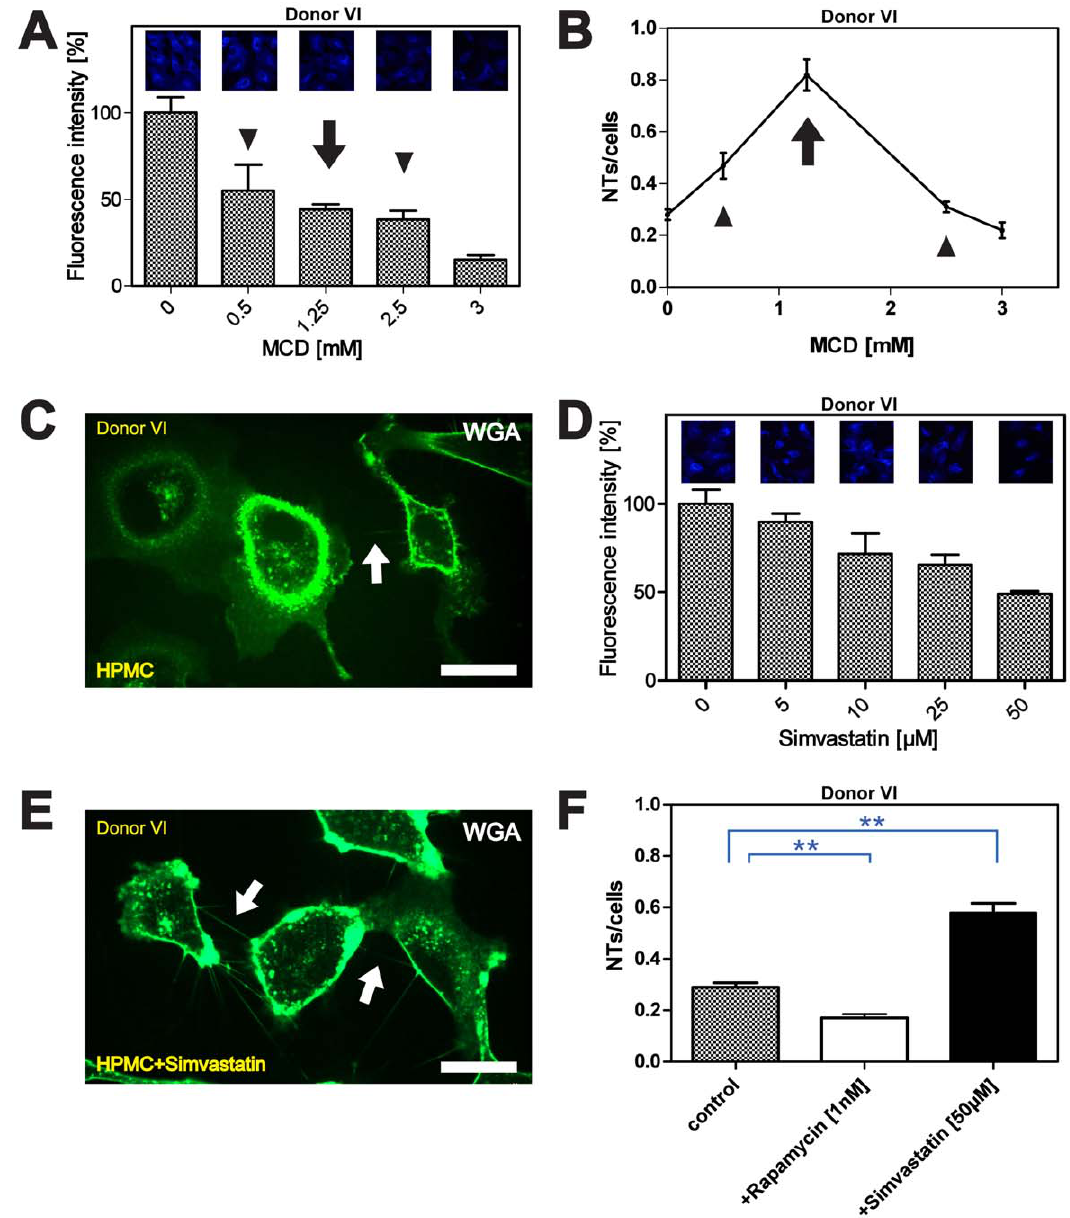
Figure 4. Influence of MCD and simvastatin on NT formation between HPMCs. ( A ) HPMCs from Donor VI were cultured in absence or presence of indicated MCD concentrations and Filipin III staining was performed one hour after plating. Cholesterol depletion results in a decrease of fluorescence intensities (arrowheads, arrow). ( B ) Analysis of the NTs/cells ratio dependent on cholesterol depletion. HPMCs were treated with indicated MCD concentrations and NT numbers were assessed one hour after cell plating. The graph shows a significantly higher number of NTs when cells are treated with 1.25 mM MCD (arrow) as compared to the control or treatment with 0.5 mM and 2.5 mM MCD (arrowheads). ( C ) Live-cell fluorescence microscopy showing NTs (arrow) between the cells under control conditions one hour after cell plating. Scale bar: 20 m m. ( D ) Quantitative analyses of fluorescence intensities after cholesterol staining with Filipin III. Filipin staining was performed in the presence of indicated concentrations of simvastatin as described. For quantification, fluorescence intensities based on representative microscopic images (top row) were determined as described. Increasing concentrations of simvastation resulted in a linear decrease of fluorescence intensities. ( E ) Live-cell fluorescence microscopy after simvastatin treatment revealed strongly elevated NT numbers between cells (arrows) as compared to the control condition. ( F ) Quantitative analyses of the NTs/cells ratio from Donor VI after treatment with rapamycin or simvastatin. Cells were cultured in absence (control) or presence of indicated rapamycin or simvastatin concentrations and NT numbers were analyzed one hour after cell seeding. Incubation of cells with 1 nM rapamycin led to a significant decrease of NT numbers (white bar) whereas incubation with 50 m M simvastatin resulted in a strong increase (black bar). All data are means 6 SEM. ** p , 0.01 ( t -test in F